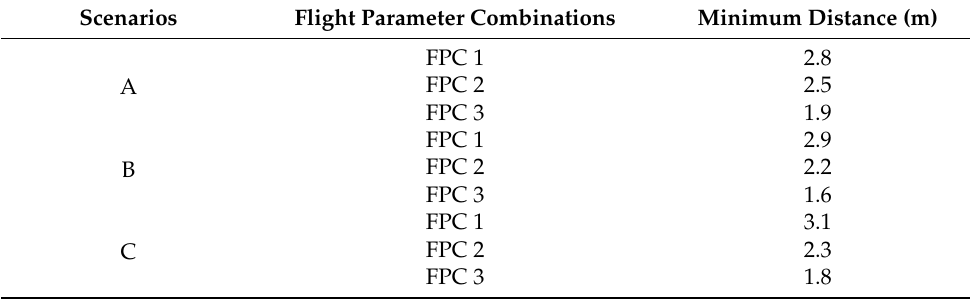
Table 6. Minimum distance between UAV and obstacle under different scenarios and